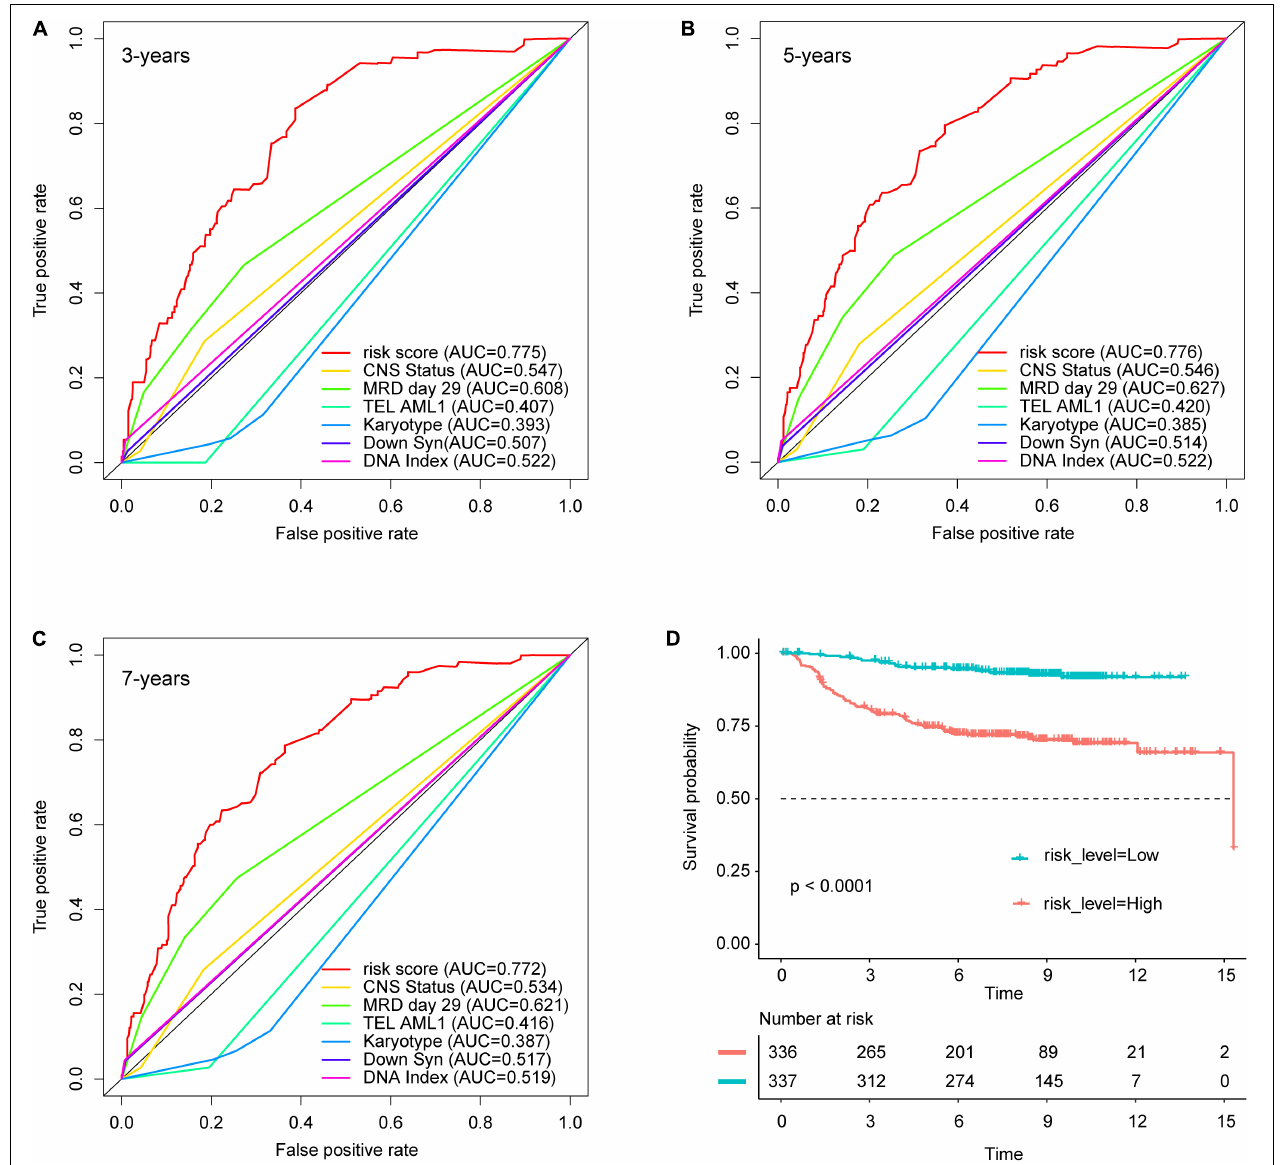
FIGURE 4 | The results of receiver operating characteristic (ROC) and Kaplan–Meier curve analyses. Comparison of survival prediction with regard to specificity and sensitivity according to the risk score and clinical characteristics in the nomogram. The areas under the curve (AUCs) for (A) 3 years, (B) 5 years, and (C) 7 years are shown in the bottom right corner of each picture. (D) Kaplan–Meier curves comparing the survival outcomes of the two groups with the assistance of the log-rank test. CNS status, central nervous system status at diagnosis; MRD 29, minimal residual disease status at day